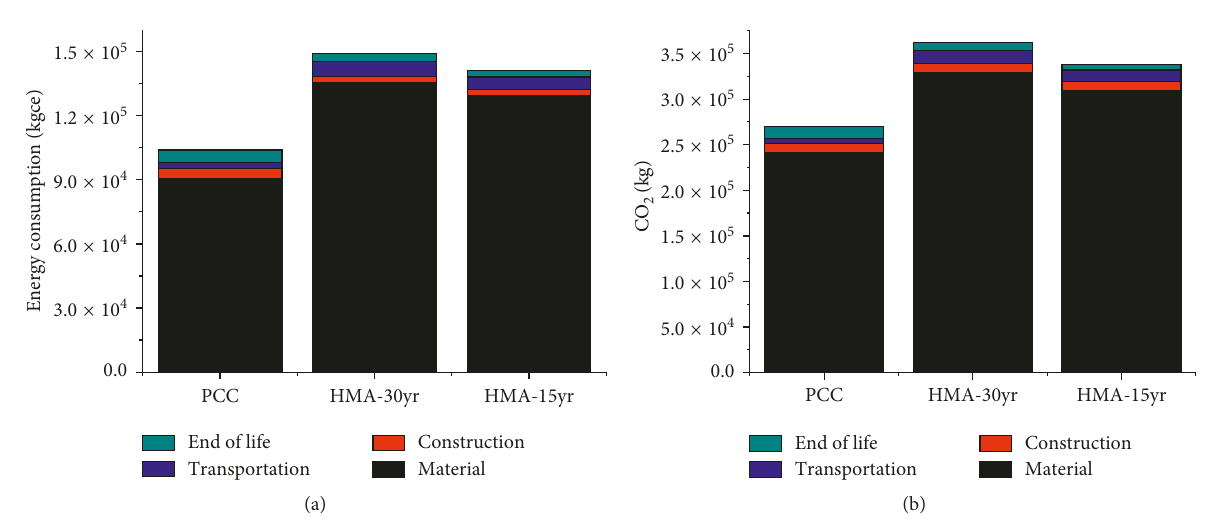
Figure 1: (a) Energy consumption and (b) CO